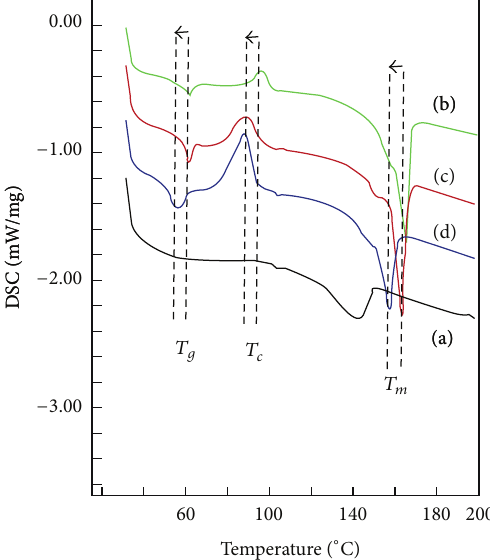
Figure 5: DSC thermogram of (a) jute CC, (b) PLA, (c) composite with 6% CC, and (d) composite with 15% CC.